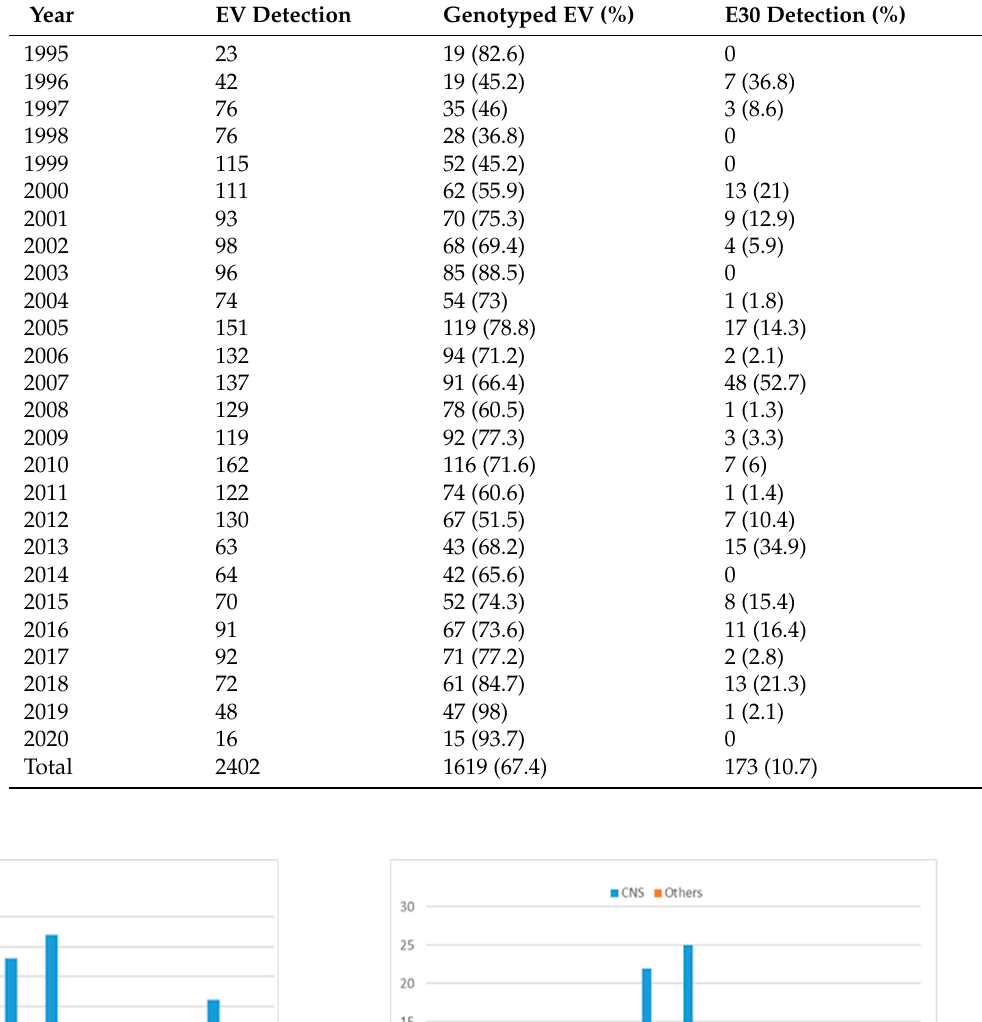
Table 3. E30 infections with respect to the total of EV genotyped by year.